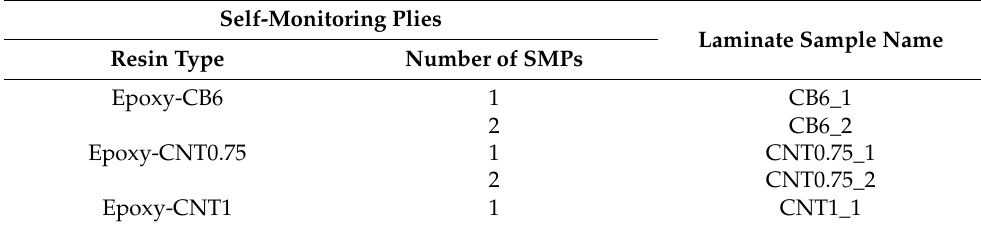
Table 2. Nomenclature of laminate